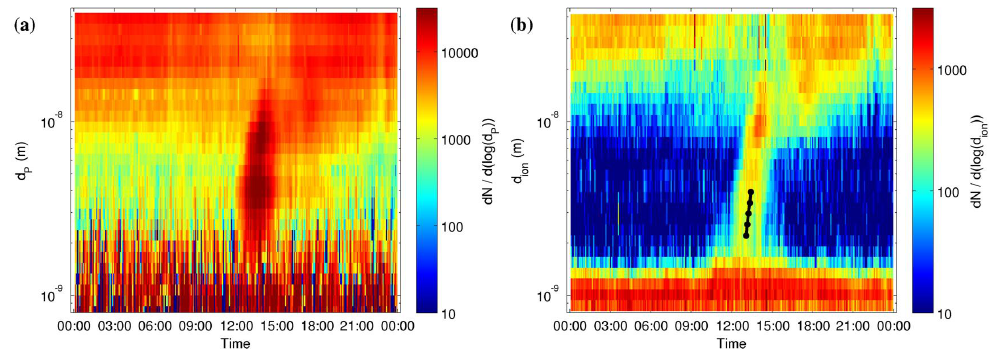
Fig. 2. Nucleation event recorded with the NAIS in Hohenpeissenberg on 21 September 2008. Panel (a) presents the total particle size distribution as a function of time. Corresponding particle concentrations are shown in colour. From this day, the data points measured between 11:30 and 14:50 were used in the analysis. Panel (b) shows the simultaneously measured size distributions of negative air ions. Growth rate between 2 and 4nm is determined based on the maxima (black circles) of the normal distribution functions fitted in the concentration time series of size channels during the event. Note the different concentration scales in panels (a) and